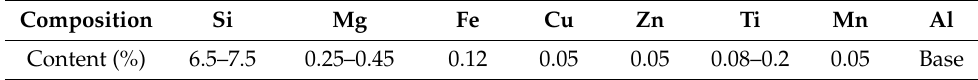
Table 3. Composition of A356 alloy.